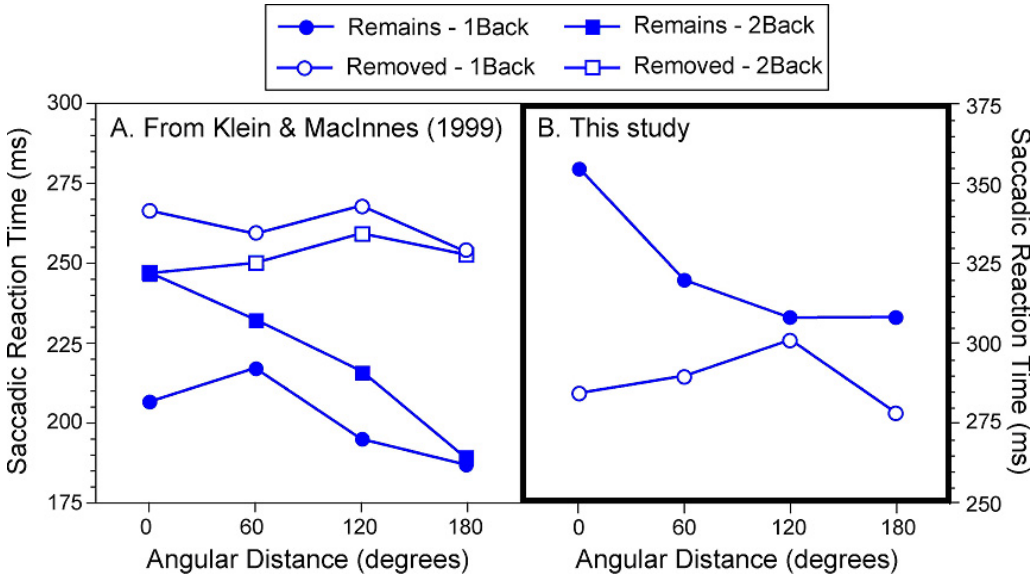
FIGURE 2. Saccadic Reaction time to foveate the probe when it was acquired in a single saccade from Klein and MacInnes ([1], Experiments 1 & 2 (a) and the current study (b). In this and all subsequent data figures, the data from the present study are highlighted by the thicker outline